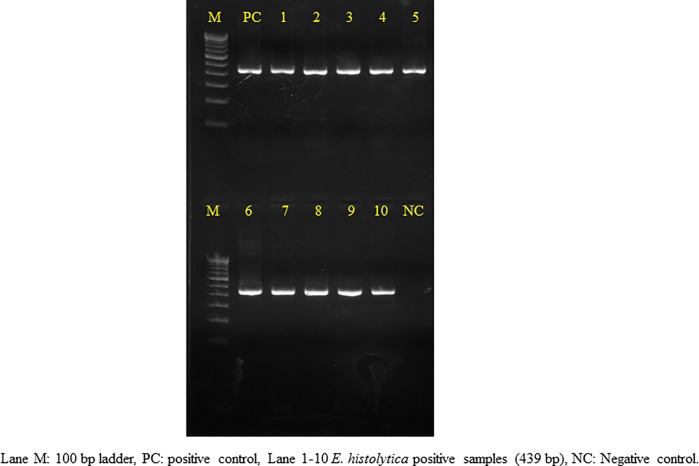
Agarose gel electrophoresis showing presence of E. histolytica in the liver aspirate samples.